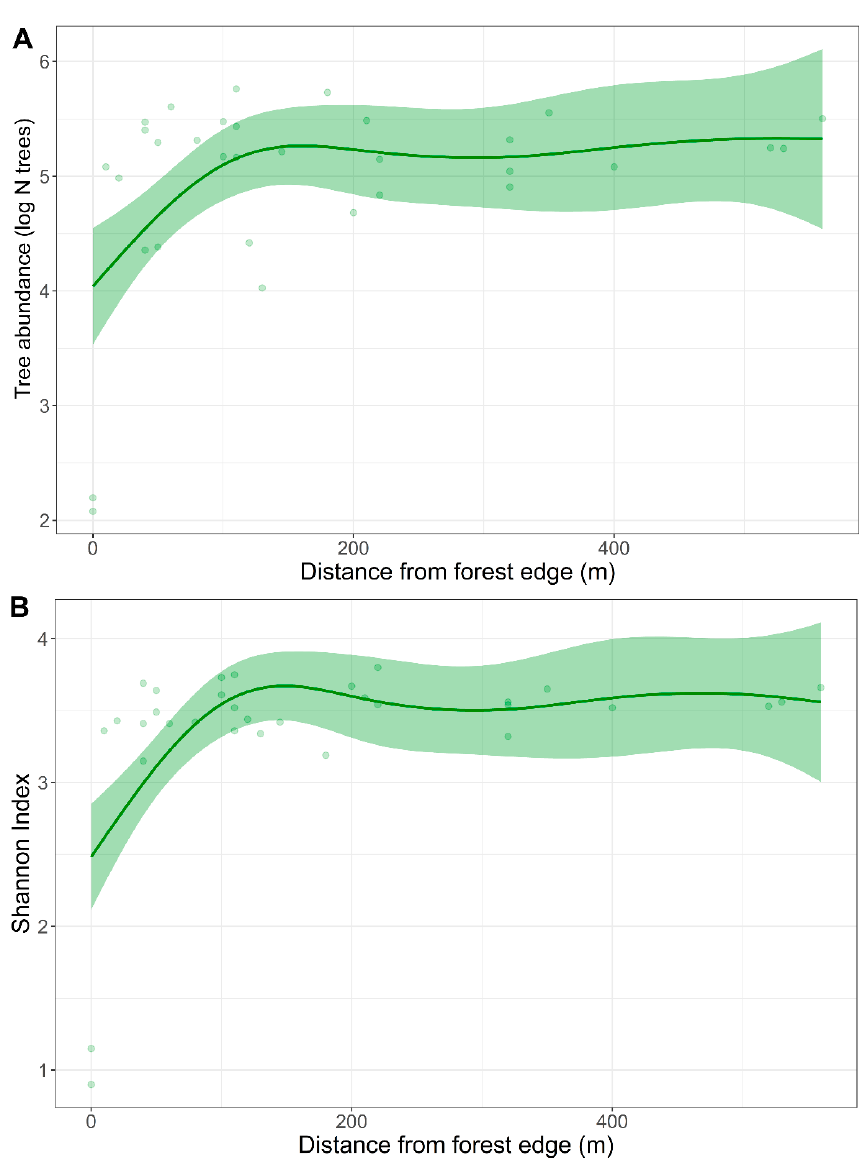
Figure 2. Significant results of the Generalised Additive Models to test the effect of distance from the forest edge on four vegetation parameters. The vegetation parameters are based on 33 vegetation plots at the Ampasy research station, north of the Tsitongambarika lowland rainforest, southeast Madagascar.